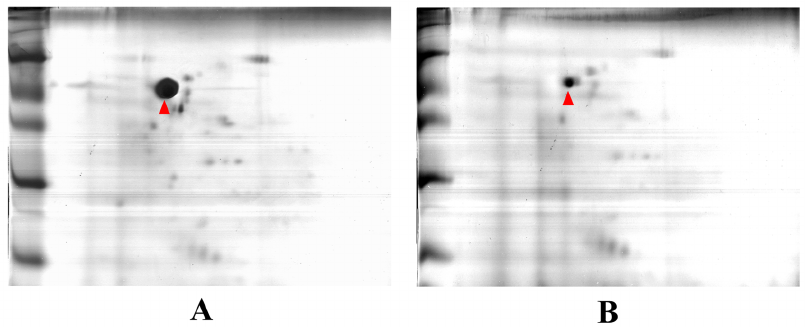
Figure 3. 2-D gel electrophoresis patterns. 2-D gel electrophoresis patterns of proteins isolated from cells of E. coli O157:H7 EDL933 (A) and its isogenic mutant derivative EDL933 D Z5898 (B). Rainbow marker was used as standard molecular weight. The sizes for each band were labelled. The spots indicated by arrowheads were flagellin identified by mass spectrometry.